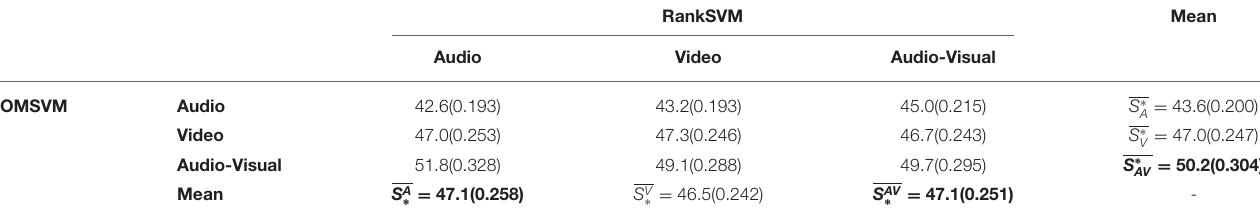
TABLE 7 | Performance of Valence prediction in terms of Unweighted Average Recall (UAR %) and weighted kappa k w (reported inside